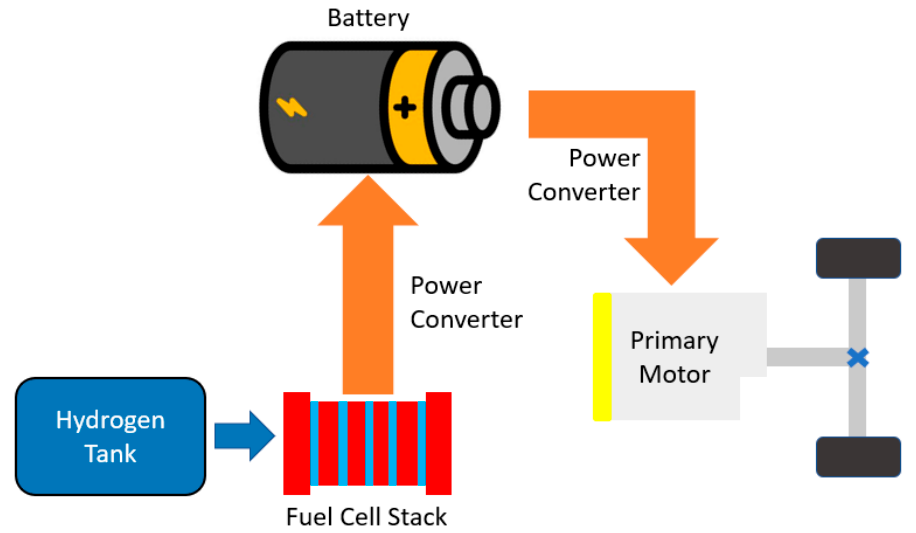
Figure 4. Architecture of a powertrain with fuel cell as range extender.